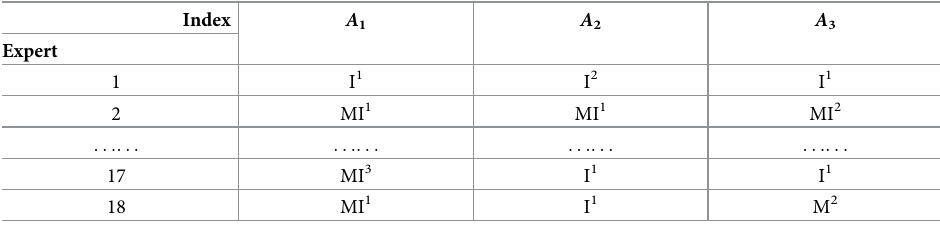
Table 7. Findings on the importance of expert segment